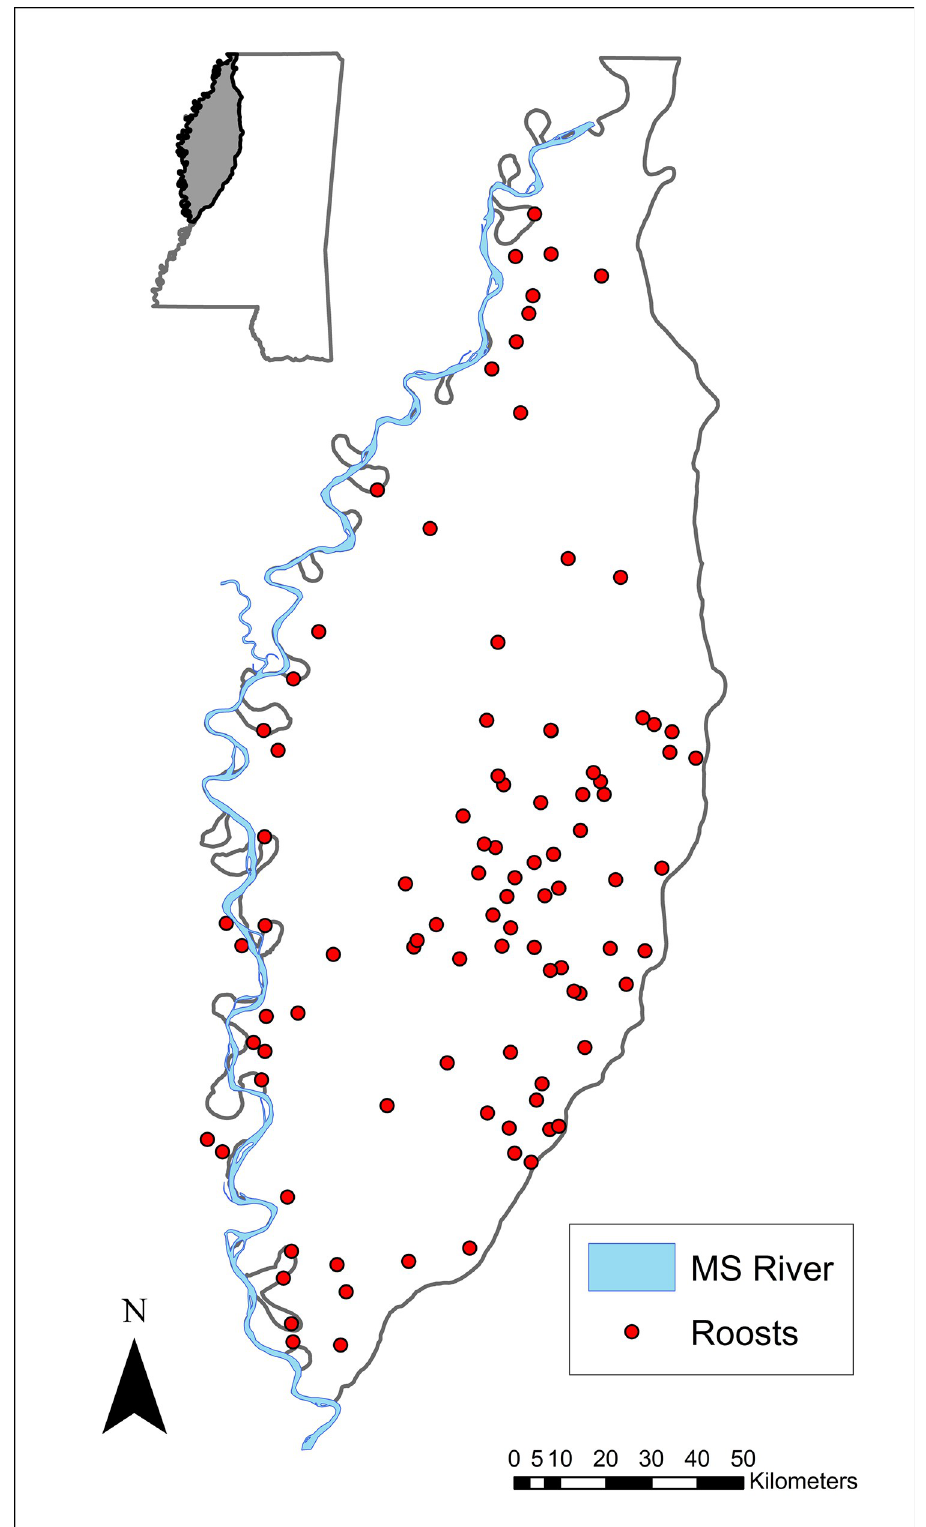
Fig 1. Portion of the Mississippi alluvial valley located in Mississippi, known as the Mississippi Delta. Abundance data of cormorants at roosting sites (red points) were collected by USDA WS-NWRC during winter months